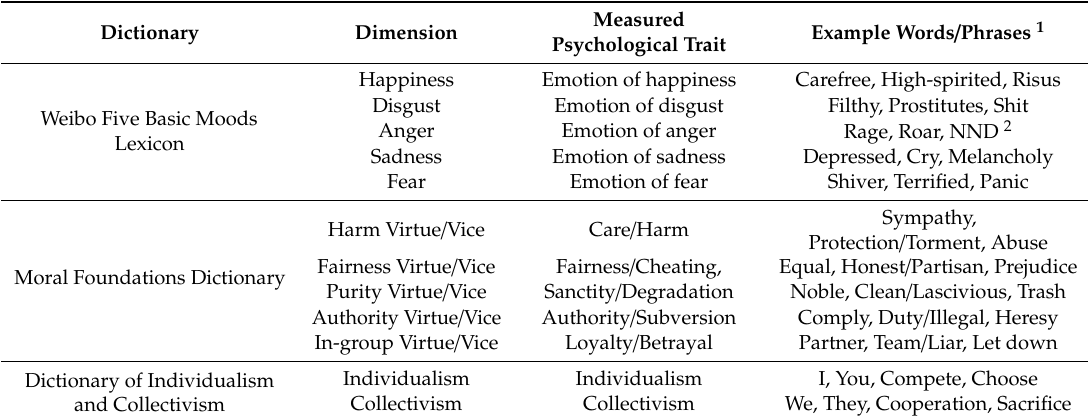
Table 3. Details on dictionaries